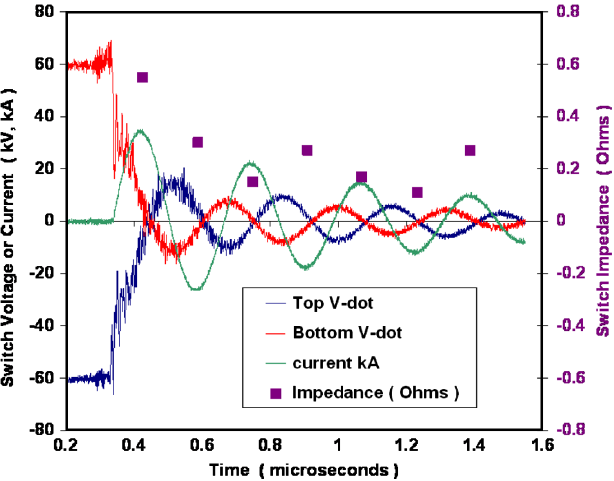
FIG. 20. (Color) Plots of brick current and Sandia switch im- pedance when the brick with the Sandia switch was charged to (cid:2) 60 kV and then discharged into a short-circuit load. Three different assumptions for switch inductance ( L ) are shown. Only the middle plot, with L ¼ 30 nH gives physically reasonable